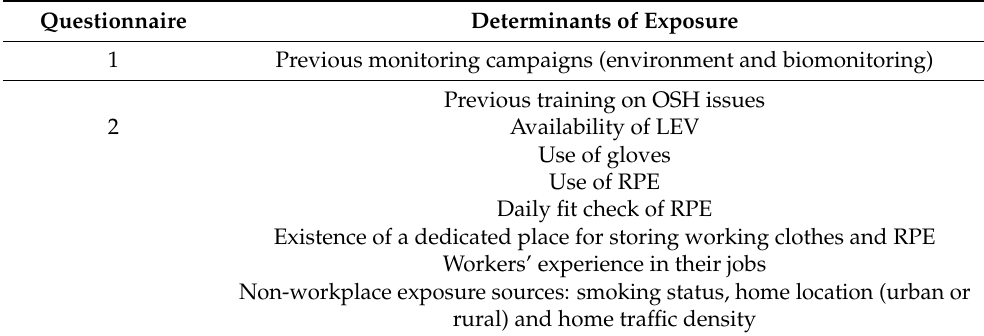
Table 1. Collection of information on exposure determinants by